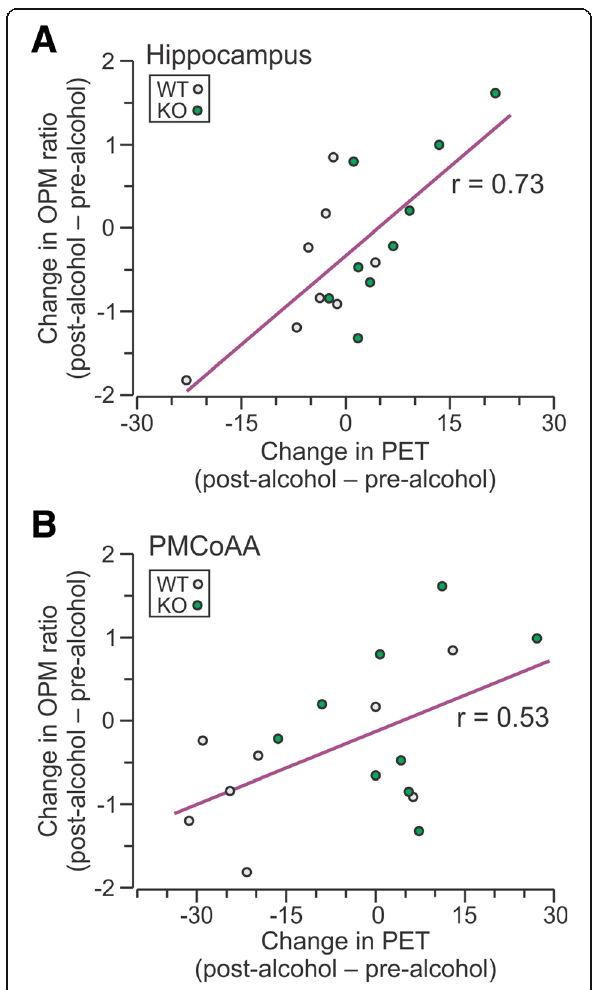
Fig. 5 Regional metabolic activity is correlated with spatial cognition after binge alcohol. Pearson correlation analysis of percent changes in globally normalized metabolic values in the WT (open circles) and CIRP − / − mice (closed circles) with changes in OPM ratio of the hippocampus ( r = 0.73, P < 0.001) and posteromedial cortical amygdaloid area (PMCoAA; r = 0.53, P =